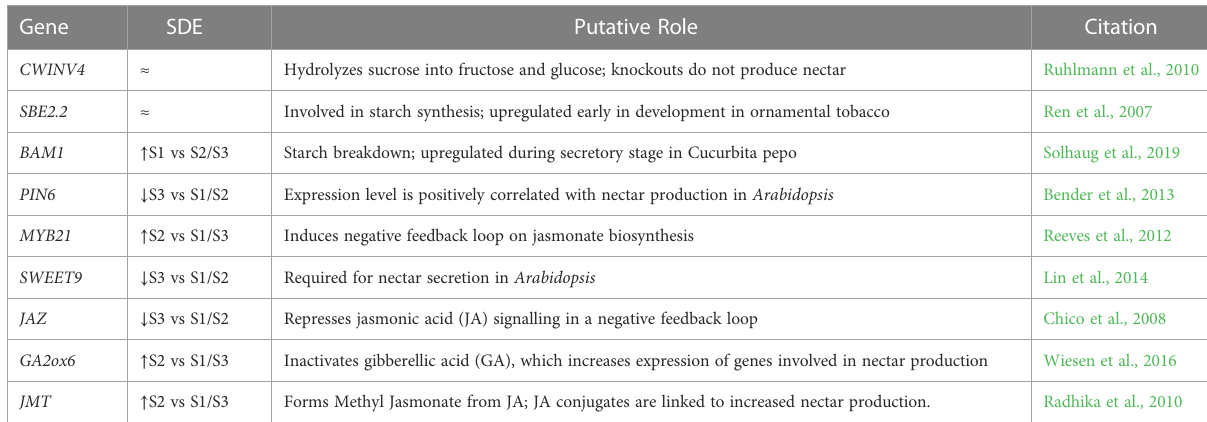
SDE, Signi fi cant Differential Expression with arrows representing either up or down regulation of expression between developmental stages ( ≈ indicates no SDE). S1, pre-anthetic nectary; S2, anthetic nectary; S3, post-anthetic